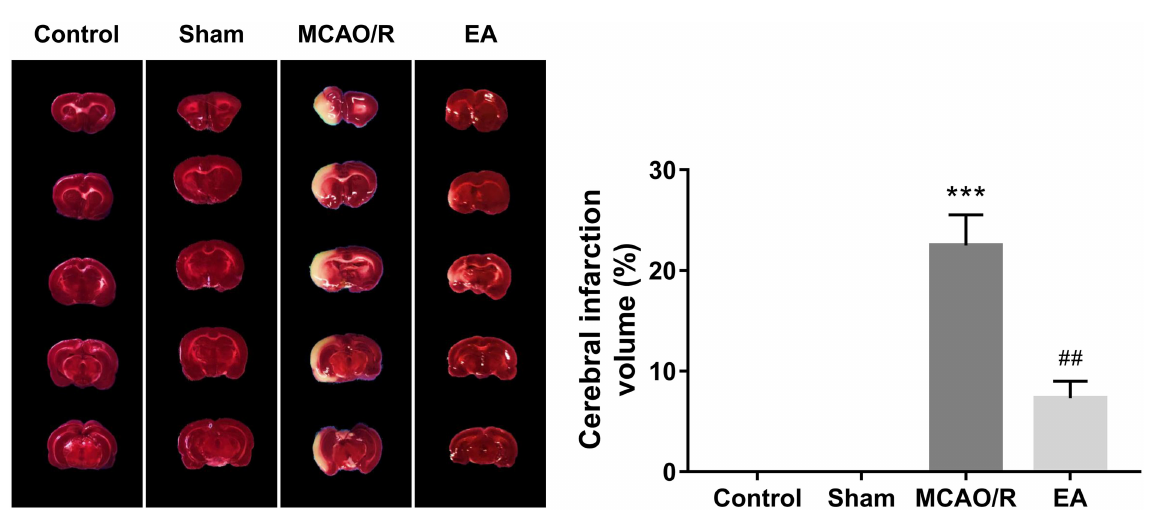
FIGURE3 EA treatment at the GV20 and GV24 alleviated MCAO/R-induced rat cerebral infarction. On Day 14 after EA treatment, the whole brains of rats were isolated and then stained with TTC. The cerebral infarction areas were stained white. Each group contained three brain samples from three rats, and five coronal sections were obtained from each brain. Compared with the sham group, *** P < 0.001; compared with the MCAO/R group, # P < 0.05, ## P < 0.01, ### P < 0.001.